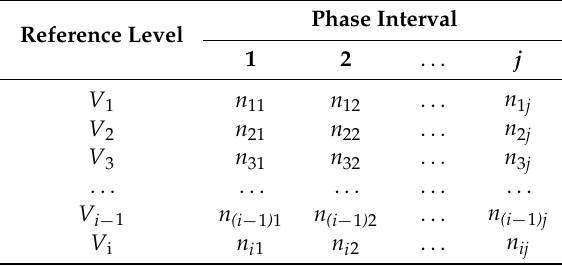
Table 1. The table of data output from the intelligent